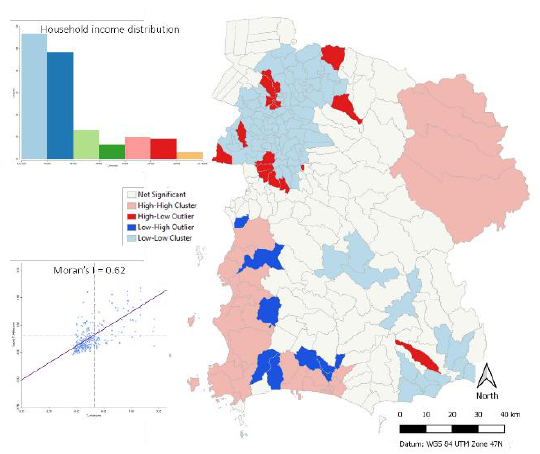
Figure 6. The distribution, spatial autocorrelation (Moran’s I), and clustering map of sub-district household income in 2016.